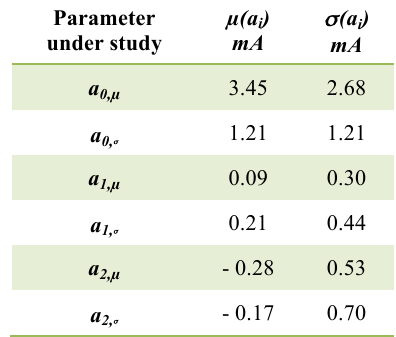
Table 1: Statistical moments of the Experimental Design applied to the mean end-current magnitude | I out | and to its standard deviation with factors 1 and